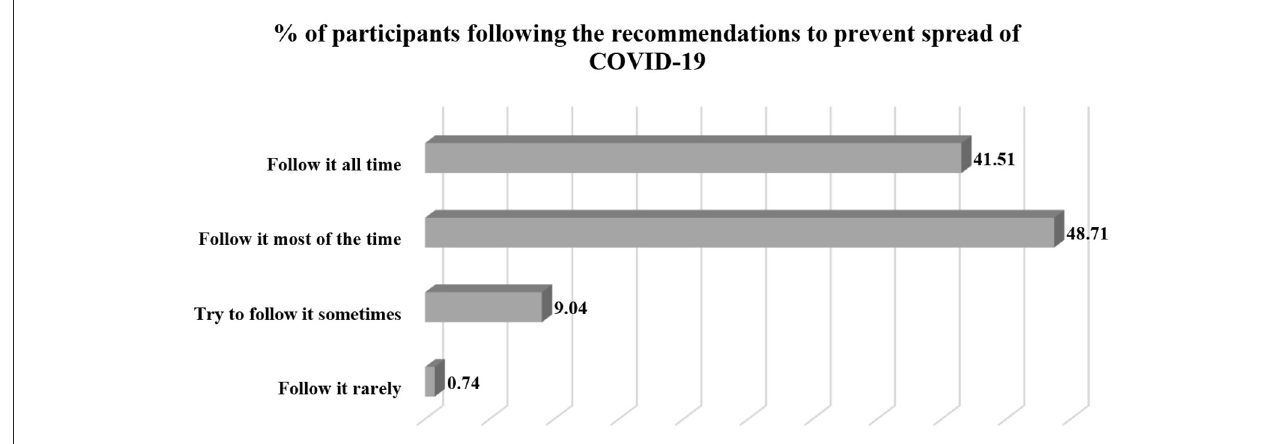
FIGURE1 Percentage distribution of participants regarding compliance to COVID-19 prevention guidelines.